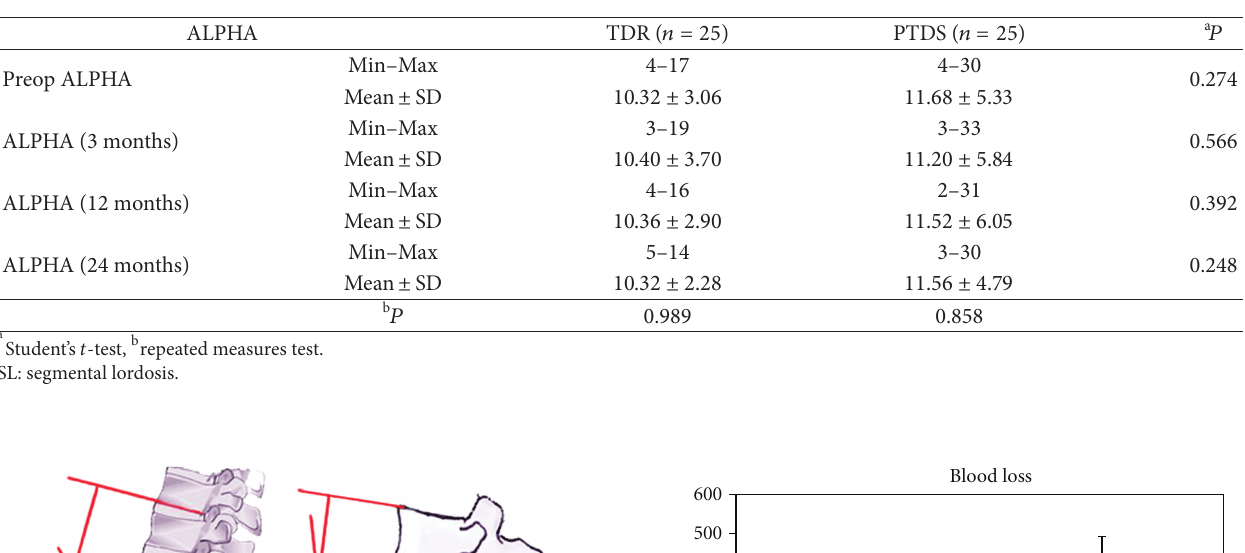
T 5: e comparison of SL (